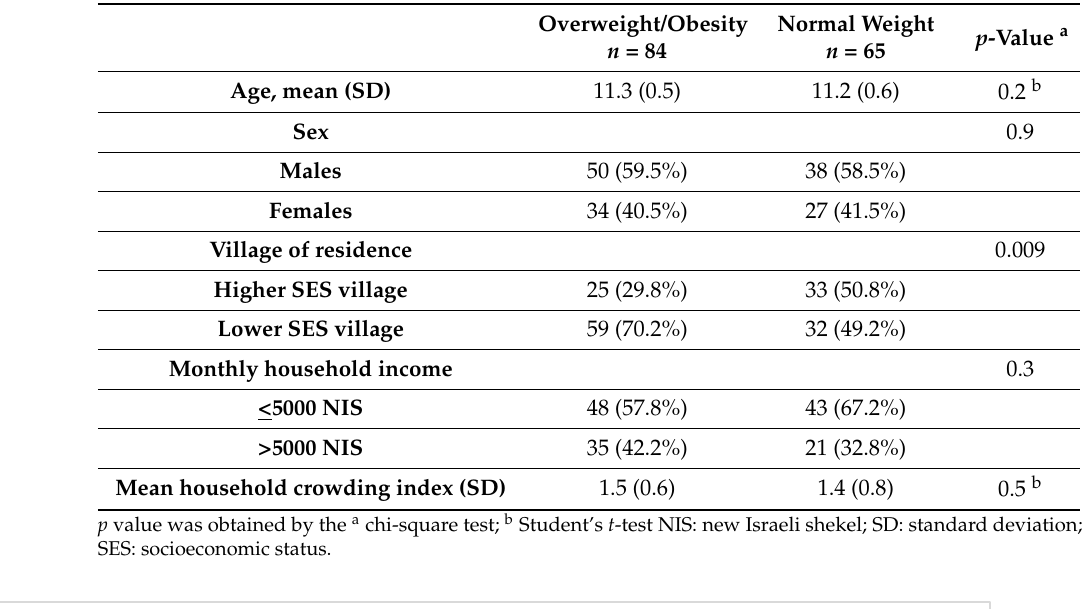
Table 1. Sociodemographic characteristics of the participants according to weight category.